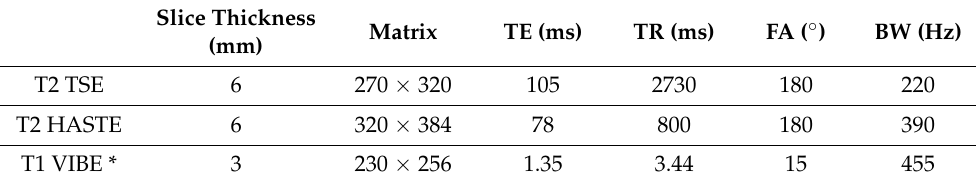
Table 2. Parameters of MRI pulse